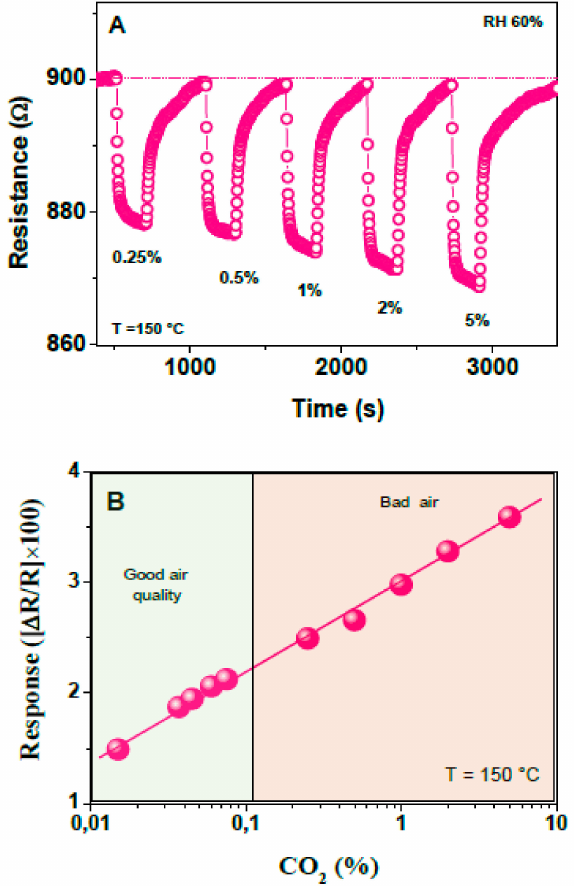
Figure 12. ( A ) Transient response of the sensor at the working temperature of 150 ◦ C exposed to CO 2 pulses of di ff erent concentration, ranging from 0.25 to 5%; ( B ) Calibration curve of the investigated sensor in a wide range of concentration (0.015 to